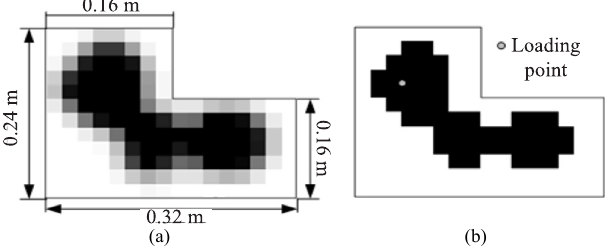
Fig. 7. Optimized topology of PCLD treatment on the “L” shape plate. (a) before post-processing; (b) after